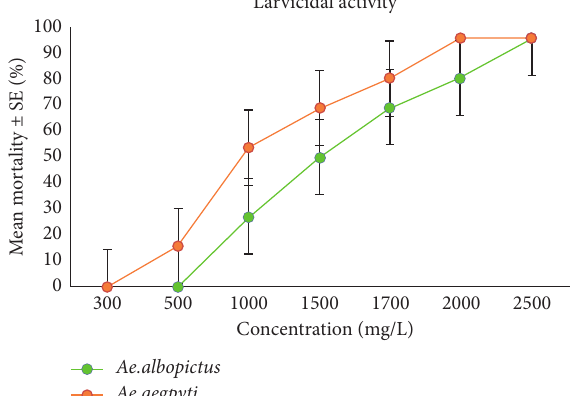
Figure 2: Comparison of larvae mortality rate between Aedes aegypti and Aedes albopictus for various Clitoria ternatea flower extract